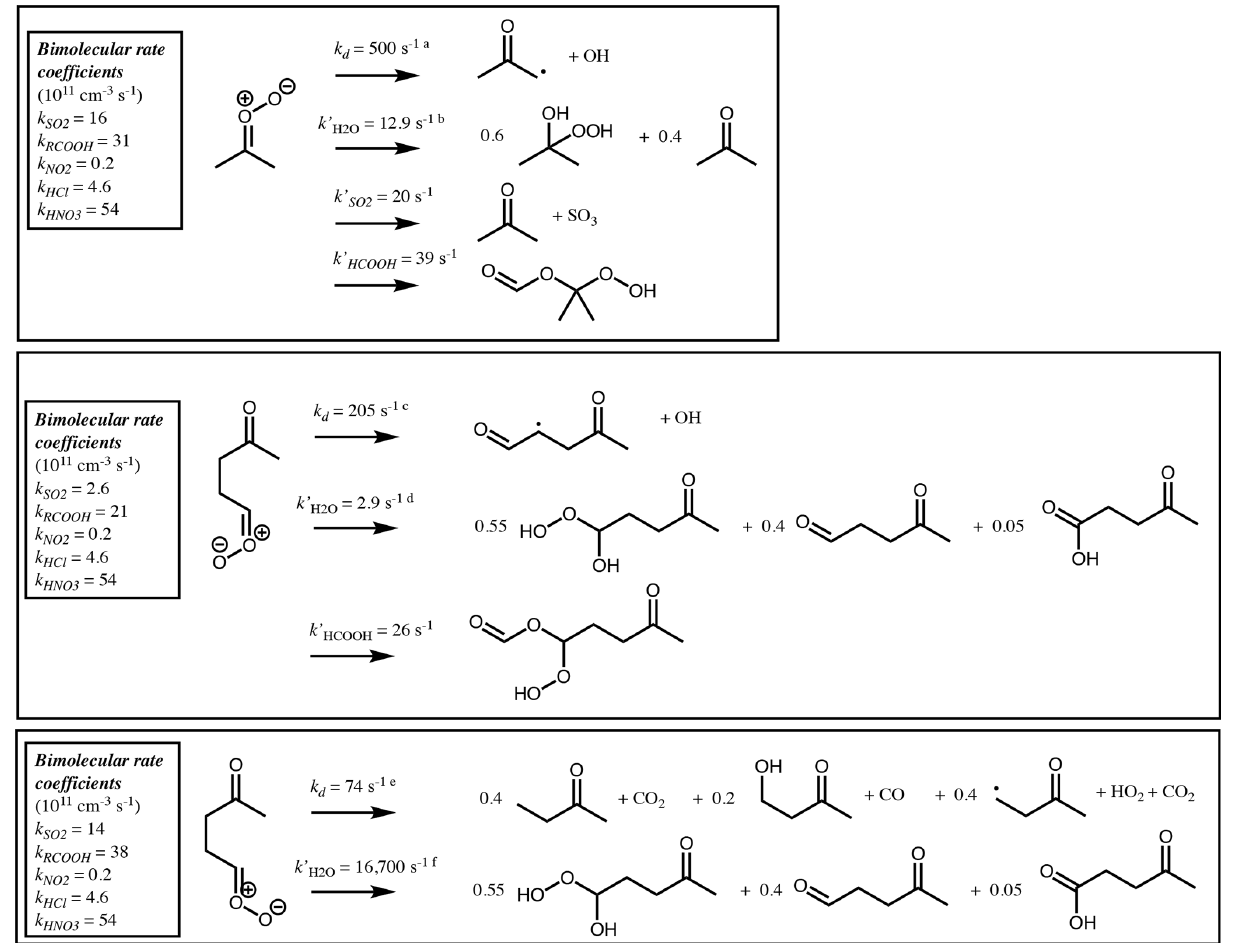
Figure 10. Bimolecular rate coefficients (see Table 3) and products of the SCI produced following ozonolysis of 6-methyl-5-hepten- 2-one at 298K. Pseudo first-order loss rates ( k (cid:48) ) and products are shown for decomposition and reaction with water vapour and for other pathways that contribute more than 1% of the total loss assuming [ SO 2 ]= 5ppbv, [ RCOOH ]= 5ppbv, [ H 2 O ]= 5 × 10 17 cm − 3 , [ (H ]= 5 × 10 14 cm − 3 , [ NO ]= 1ppbv, [ HCl ]= 100pptv and [ HNO ]= 100pptv. a 7.64 × 10 − 60 × T 23 . 59 e (2367 /T ) . b Sum of first- 2 O) 2 2 3 order loss rates to water monomer (7.54 × 10 − 18 ·[ H 2 O ] ) and dimer (1.82 × 10 − 14 ·[ (H 2 O) 2 ] ). c 2.41 × 10 − 62 × T 24 . 33 e (2571 /T ) . d Sum of first-order loss rates to water monomer (1.51 × 10 − 18 ·[ H 2 O ] ) and dimer (4.31 × 10 − 15 ·[ (H 2 O) 2 ] ). e 1.57 × 10 10 × T 1 . 03 e ( − 7464 /T ) . f Sum of first-order loss rates to water monomer (1.58 × 10 − 14 ·[ H ] ) and dimer (1.75 × 10 − 11 ·[ (H ] 2 O 2 O) 2